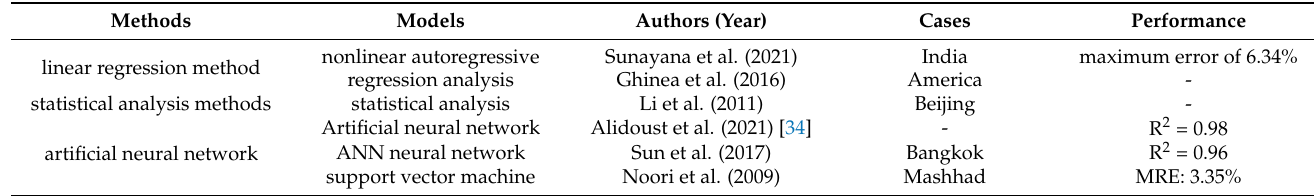
Table 1. Research and comparison on prediction of Municipal Solid Waste